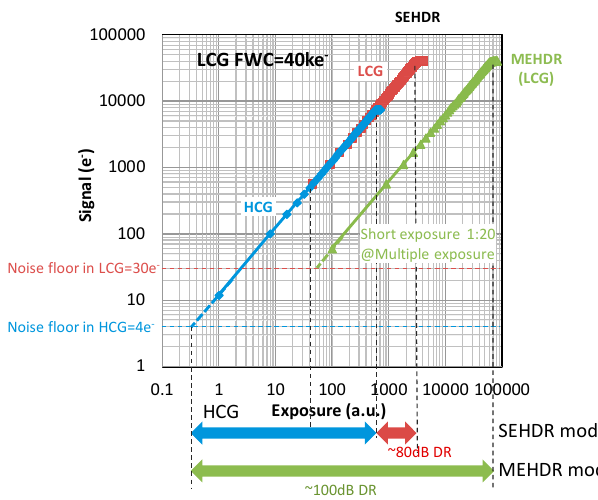
Figure 7. Photo conversion characteristics of high conversion gain (HCG) mode and low conversion gain (LCG) mode. The signal electrons were measured by changing exposure time under a constant light condition while different illuminance levels were set for the single exposure high dynamic range (SEHDR) and multiple exposure high dynamic range (MEHDR) measurements. Readout noise equivalent electrons in the HCG mode and the LCG mode were measured under the dark condition at the integration time of 300 us.